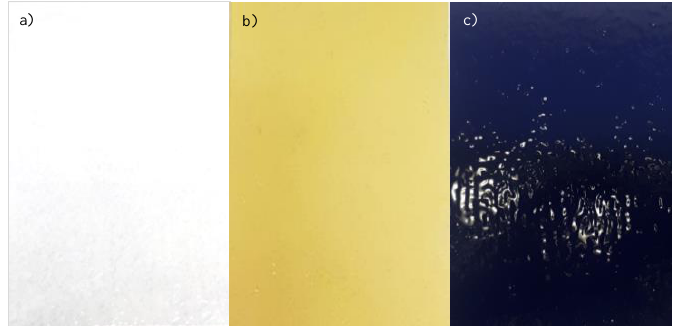
Figure 1. Image of steel samples painted with the first layer of white commercial primer ( a ), the second layer of yellow tie-coat ( b ), and the third layer of blue topcoat ( c ). We have coded each coating as “HSMX”: H represents the commercial Hempel resin (biocide-free) for the finish coating, SMX is the type of filler we synthesized and added by mixing, and X specifies its type (i.e., X = 1, 5, 6, 7) according to Table 1. Pure topcoat resin, H, was used as a reference sample. Table 1. Sample labels and chemical composition. Sample Label Sample